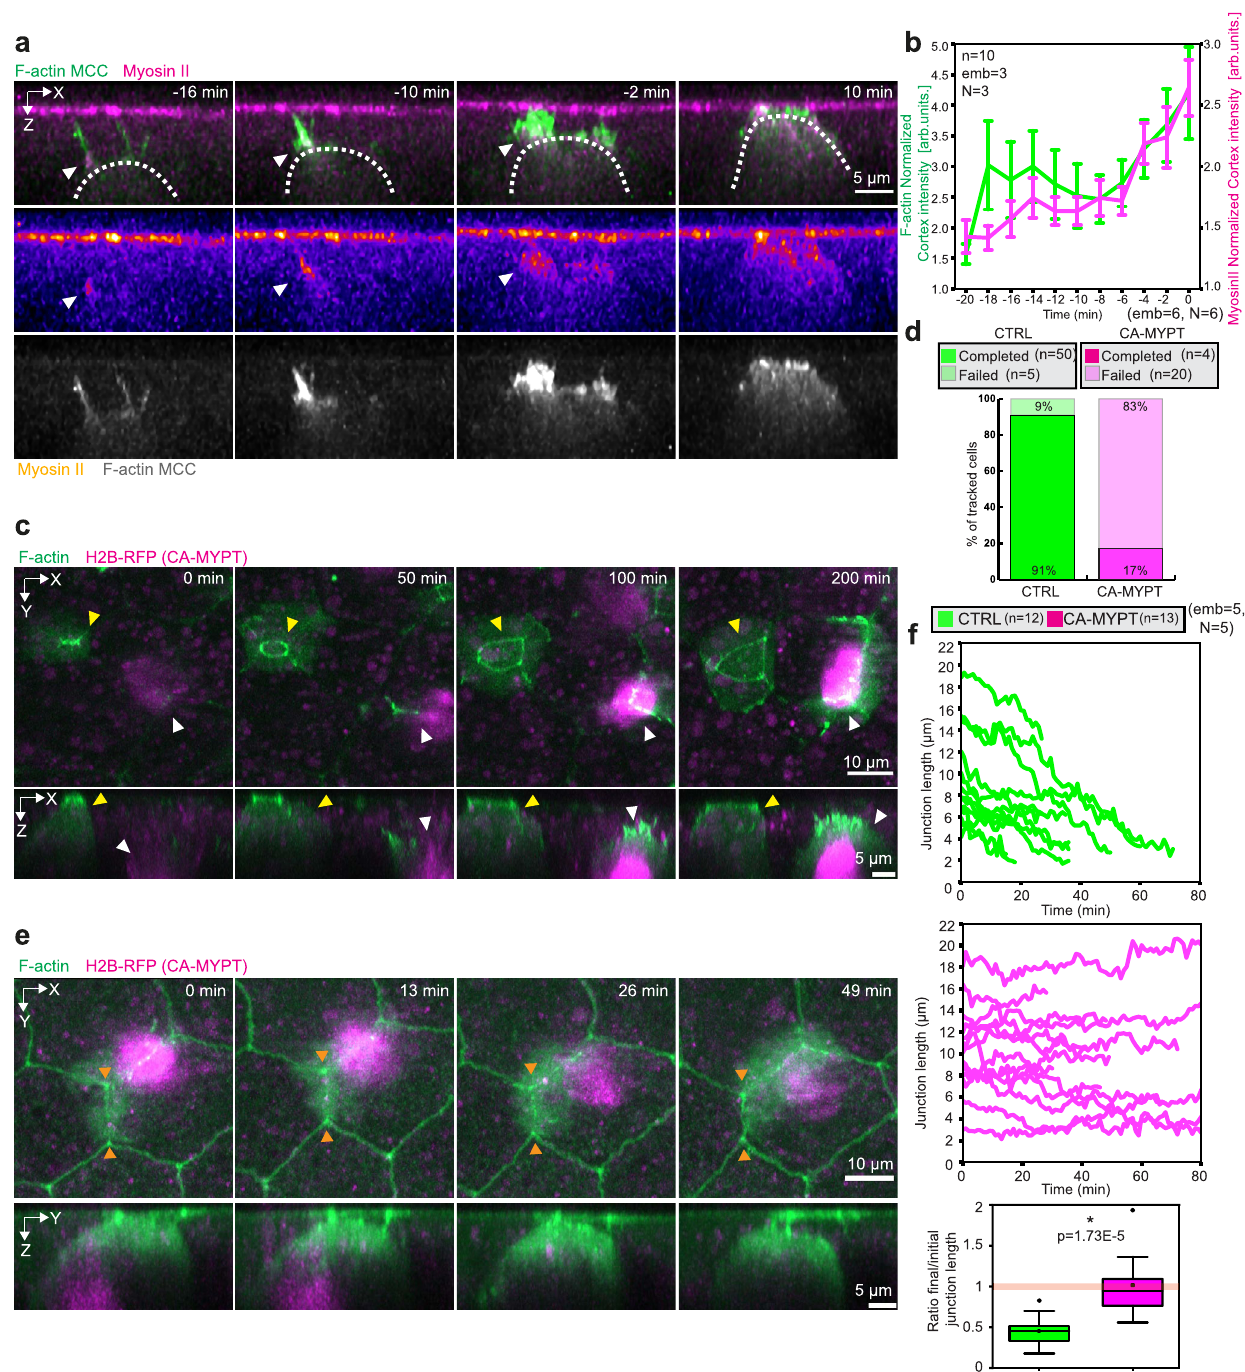
Fig. 6 | Myosin II is speci fi cally required in the MCCs for integration and epi- thelial junction remodeling. a Orthogonal (XZ) projections of myosin II recruit- ment to the MCC leading edge during integration. MCC is labeled with α - tubulin::LifeAct-GFP (pseudo-colored in green in the composite image, pseudo- colored in gray as a separate channel) and myosin-II is labeled with the myosin intrabody SF9-3xGFP (pseudo-colored in magenta in the composite image, fi re pseudo-colored as a separate channel). White arrowheads depict myosin recruit- ment. Scale bar: 5 μ m. b Normalized myosin-II intensity (magenta) and normalized F-actin intensity (green) at the cortex of integrating MCCs. T =0 marks the last tracked frame during integration ( n =10 cells from 3 embryos, N =3 experiments). Data show mean±SEM. c Image sequenceof control MCC (yellow arrowhead) and CA-MYPT-overexpressing MCC (white arrowhead, marked with H2B-RFP pseudo- colored in magenta) during integration. Control and CA-MYPT overexpressing MCC express LifeAct-GFP mRNA (pseudo-colored in green). Scale bar: 10 μ m.